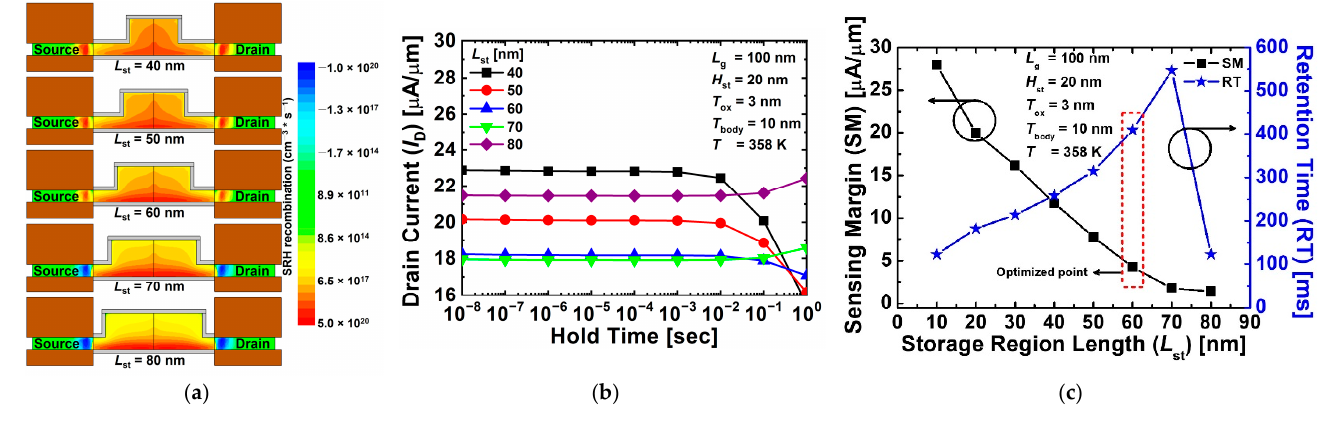
Figure 8. ( a ) Contour map of SRH recombination rate for proposed 1T-DRAM with different L st in hold state “1” operation. ( b ) Read “1” current of proposed 1T-DRAM with different L st . ( c ) Sensing margin and retention time of proposed 1T-DRAM cell as a function of L st .